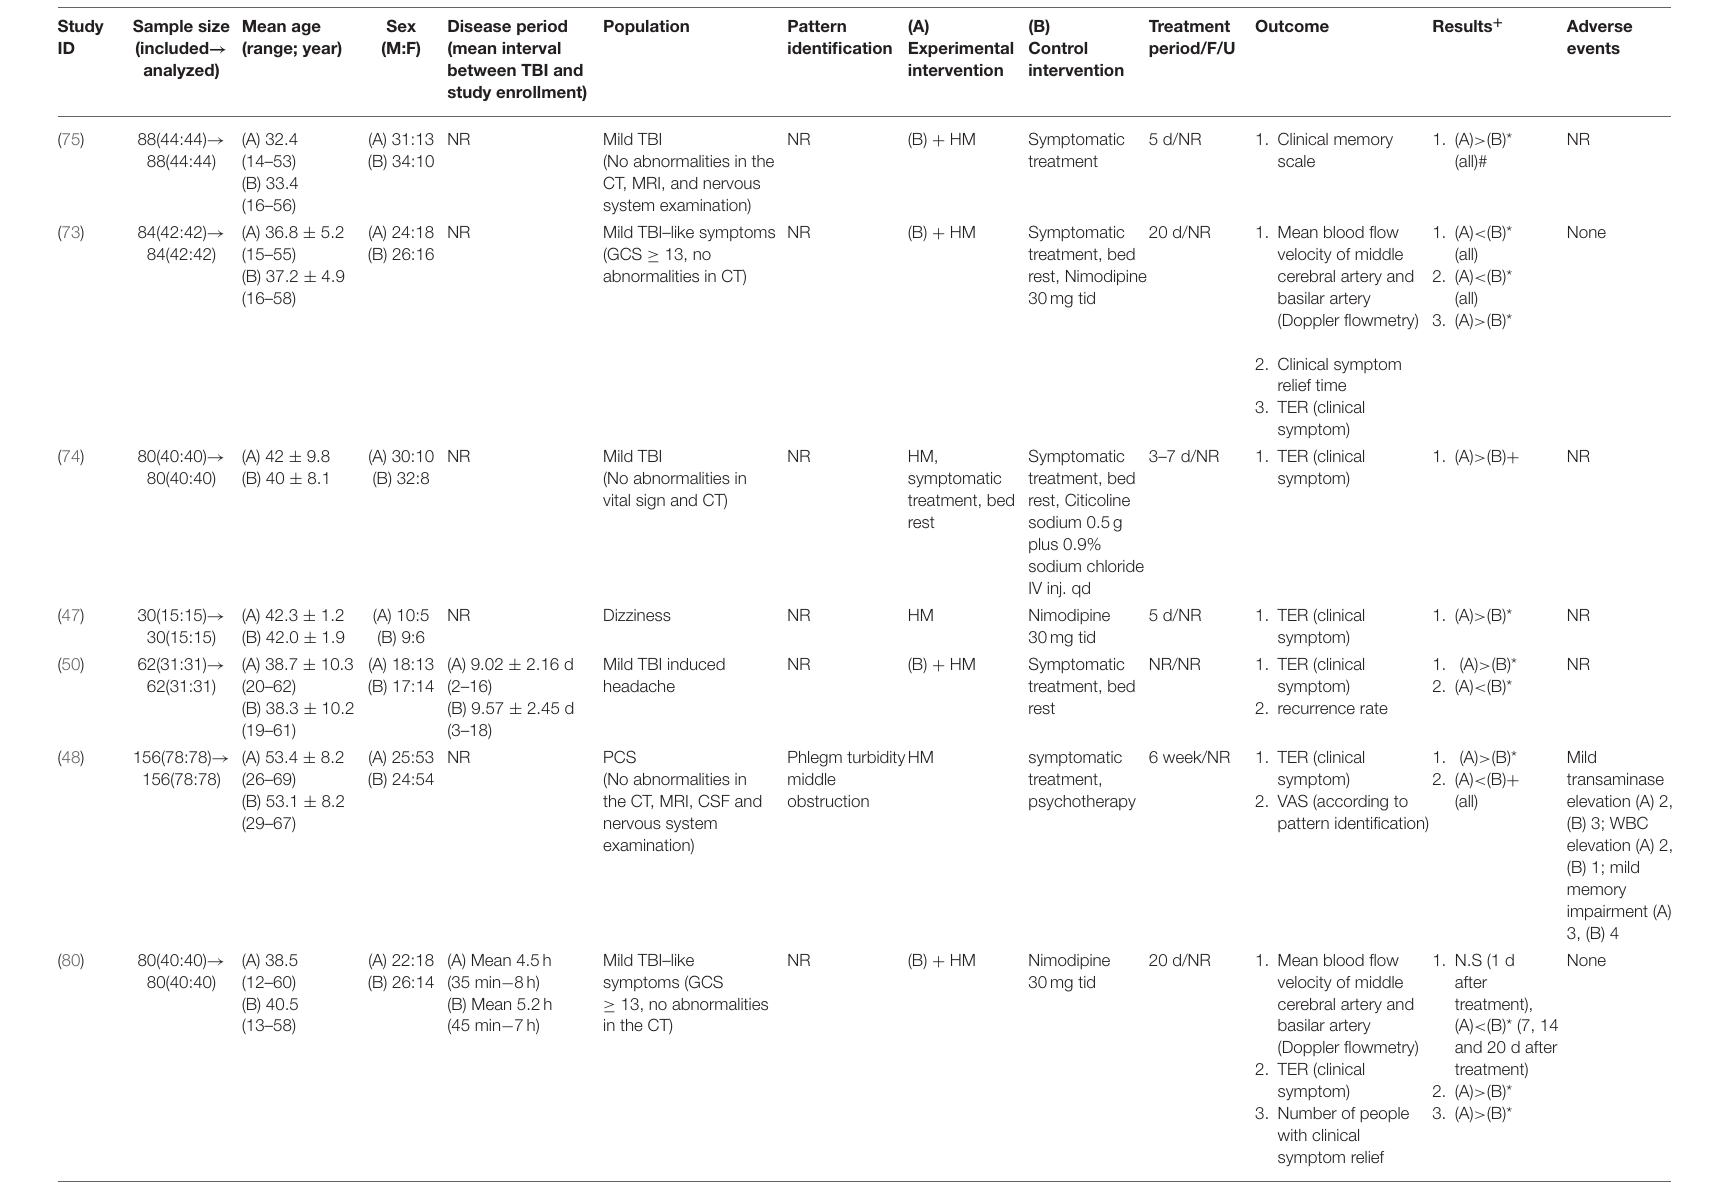
TABLE 1 | General characteristics of the included